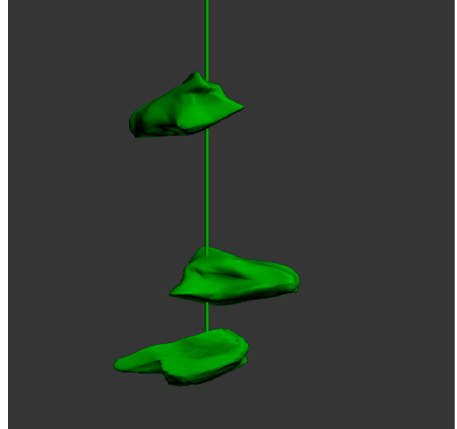
Figure 20. The three-dimensional model of the cave (h5).